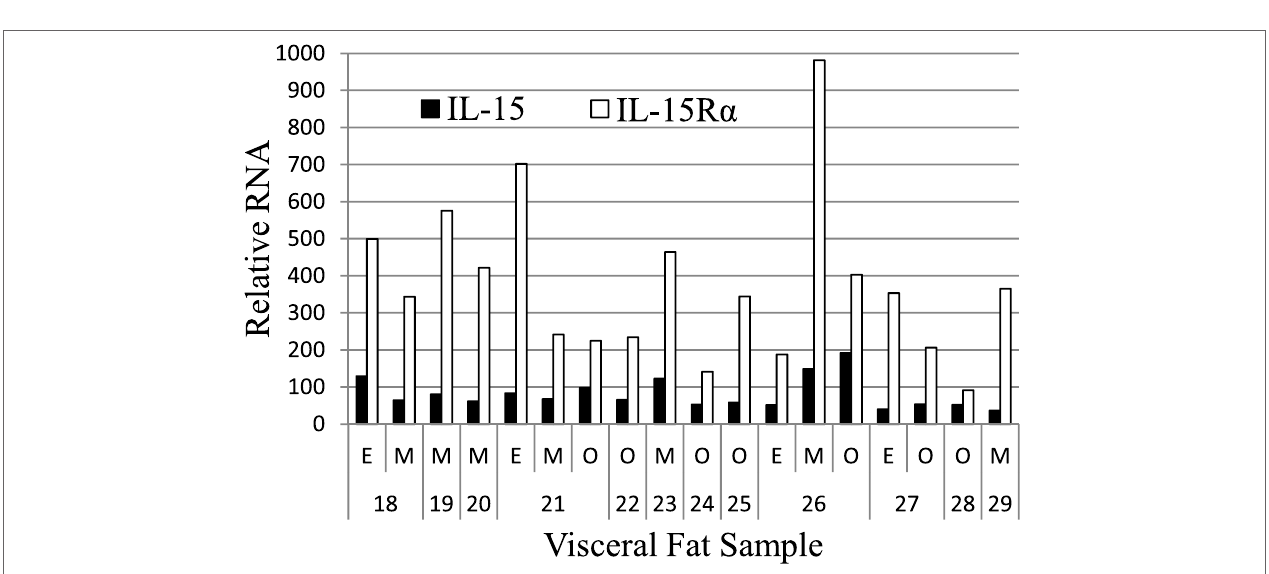
FigUre 3 | IL-15 and IL-15R α RNA are expressed in epiploic appendage (E), mesenteric (M), and omental (O) VAT. Cohort C subjects had surgeries for hernia repair (male #22, female #23, male #25), ostomy reversal (male #24), rectal intussusception (female #18), malfunctioning ileal conduit (male #19), large bowel obstruction (female #20), cancer (male #21, male #26, female #27, female #28), and acute appendicitis (male #29). Cohort C is described in Table S1 in Supplementary Material.